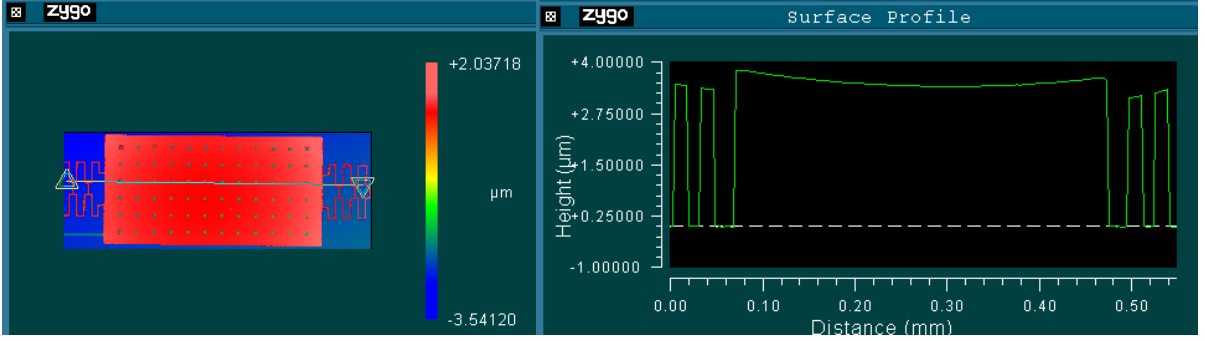
Figure 11. Surface profile of the actuator when a voltage of 15 V is applied in electrostatic attractive